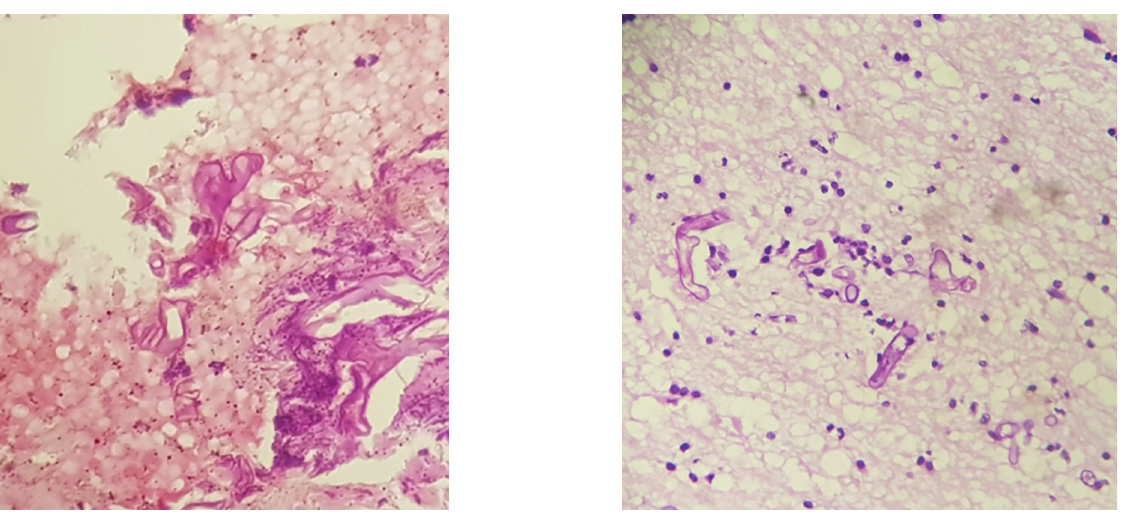
Figure 3a - White matter of the brain with glial reaction to introduction of mucormycosis hyphae, spherulas. A, branches of mucormycosis hyphae and spherules in the white matter of the brain. Hematoxylin and eosin staining,